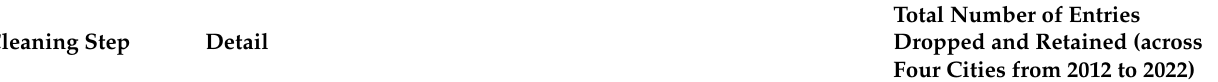
Table 1. POI data cleaning process.